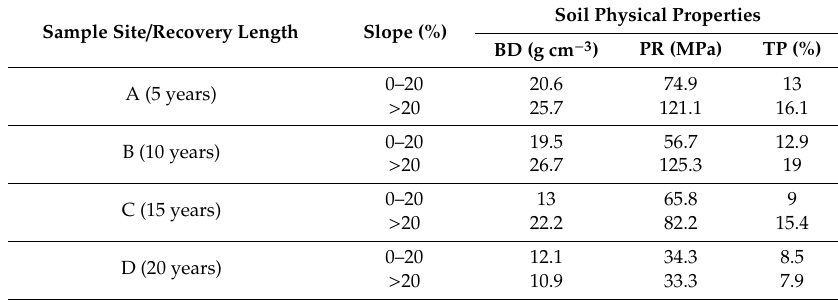
Table 7. Soil properties recovery rate (change percent in di ff erent years after the skidding operations) in two slope